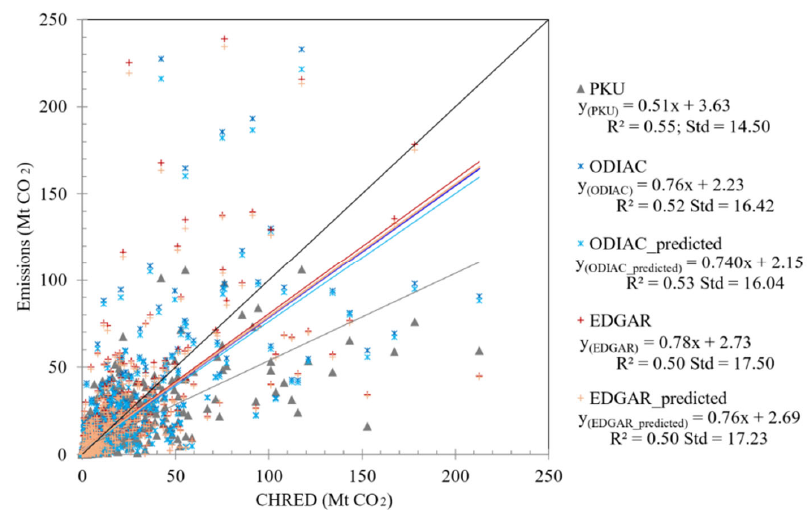
Figure 9. Scatter plot of gridded emissions in 2012 in China from CHRED emissions (x ‐ axis) in contrast to the PKU, ODIAC, and EDGAR emissions (y ‐ axis).